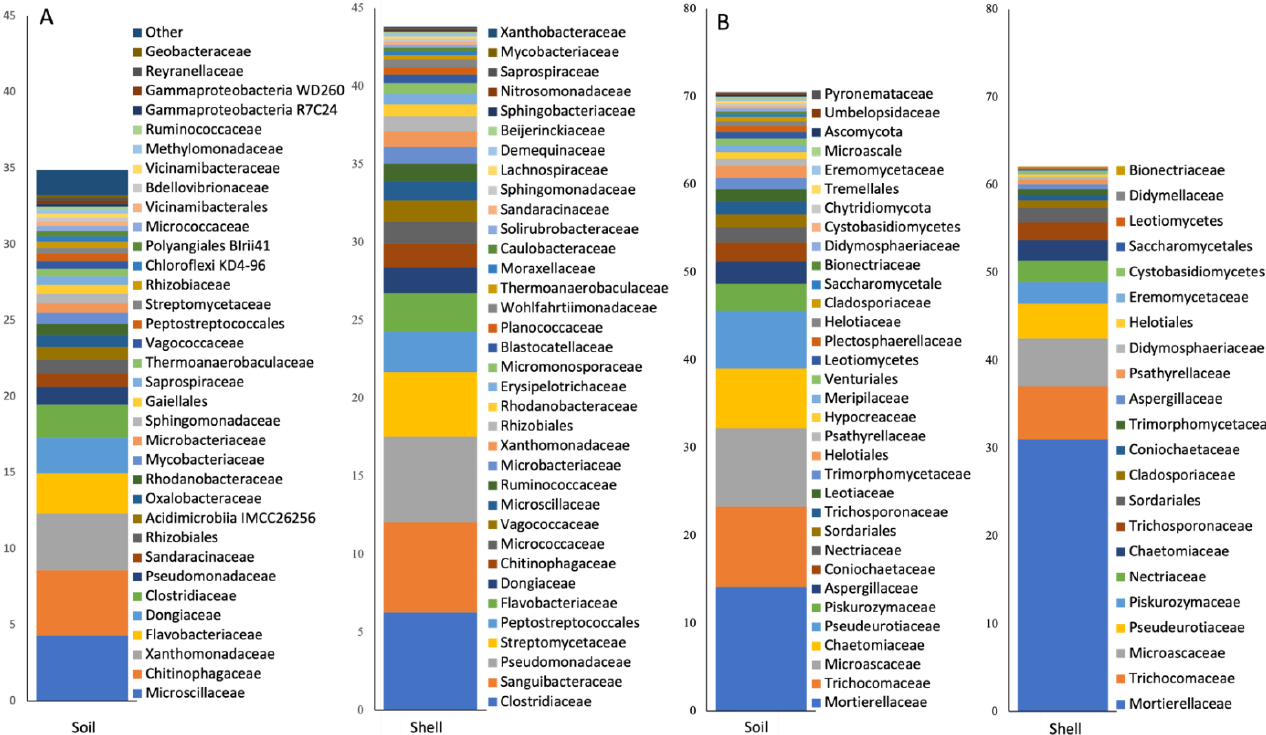
Figure 5. Microbial families identified in the core microbiomes. ( A ) Bacterial 16S rRNA; ( B ) fungal